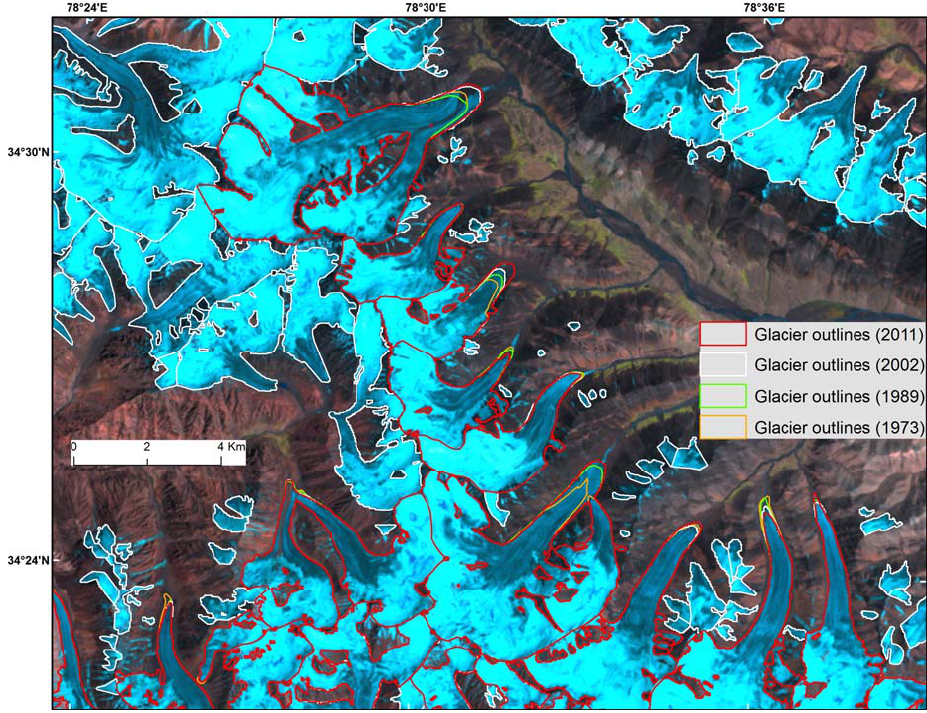
Fig. 6. Example of glacier changes in part of upper Shyok valley from 1973–2011. Background based on Landsat ETM + (2 August 2002). See Fig. 1 for location in study area.